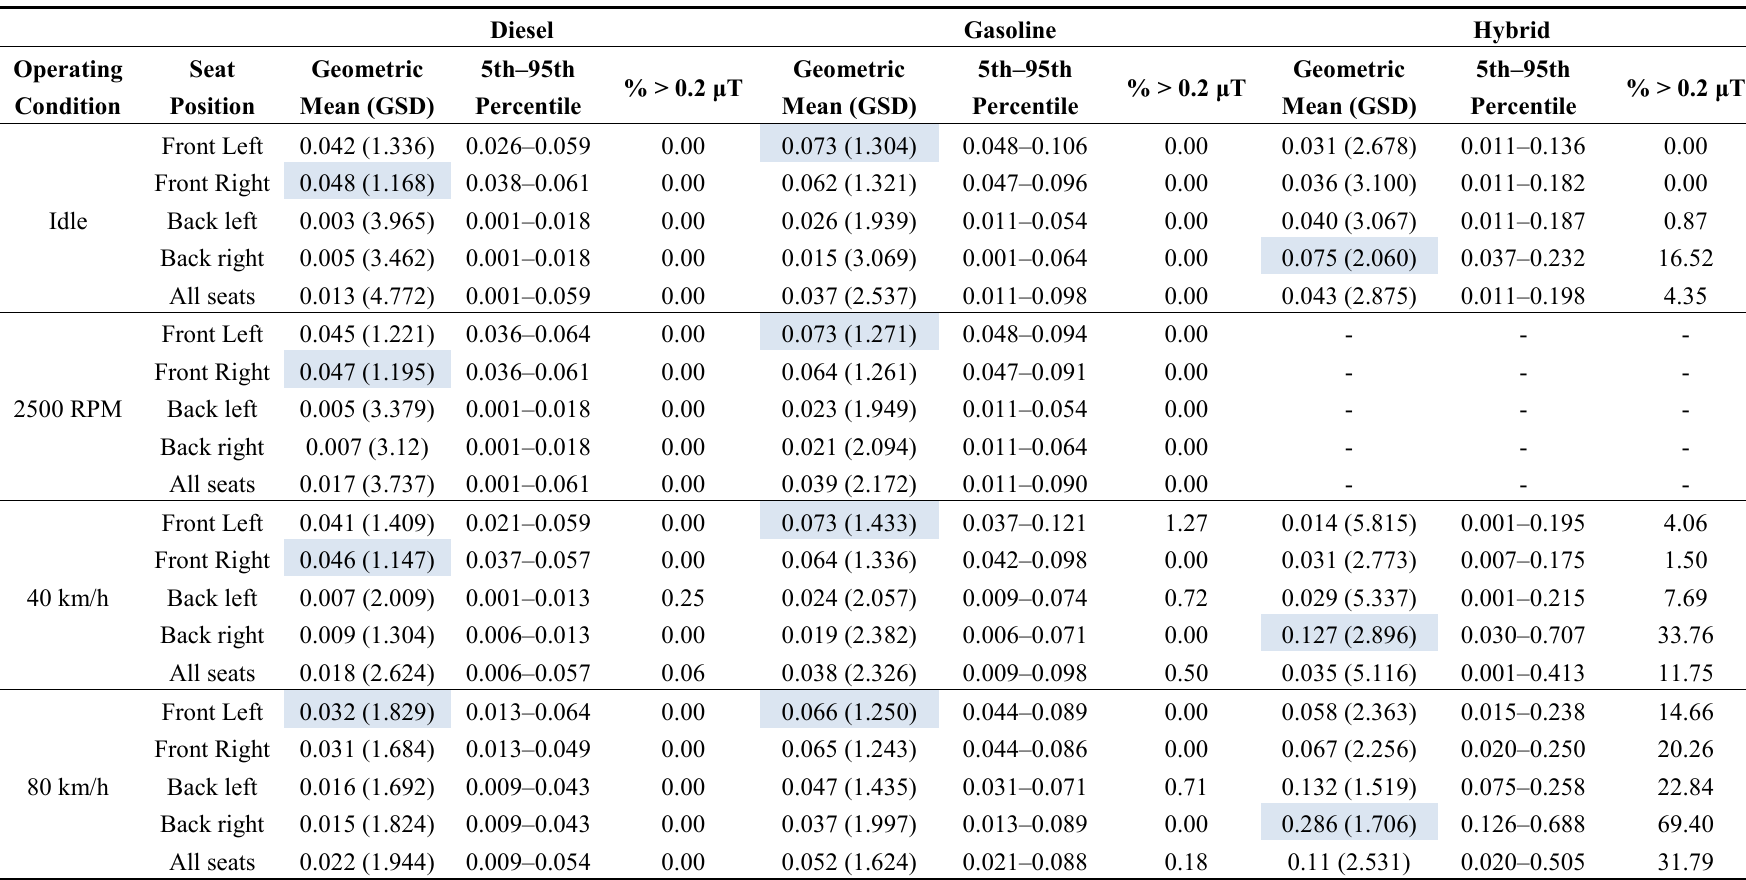
Table 3. Descriptive statistics for magnetic field measurements (μT) by operating condition and seat position stratified by engine type. Highlighted fields indicate seat position with the highest geometric mean value by engine type and operating